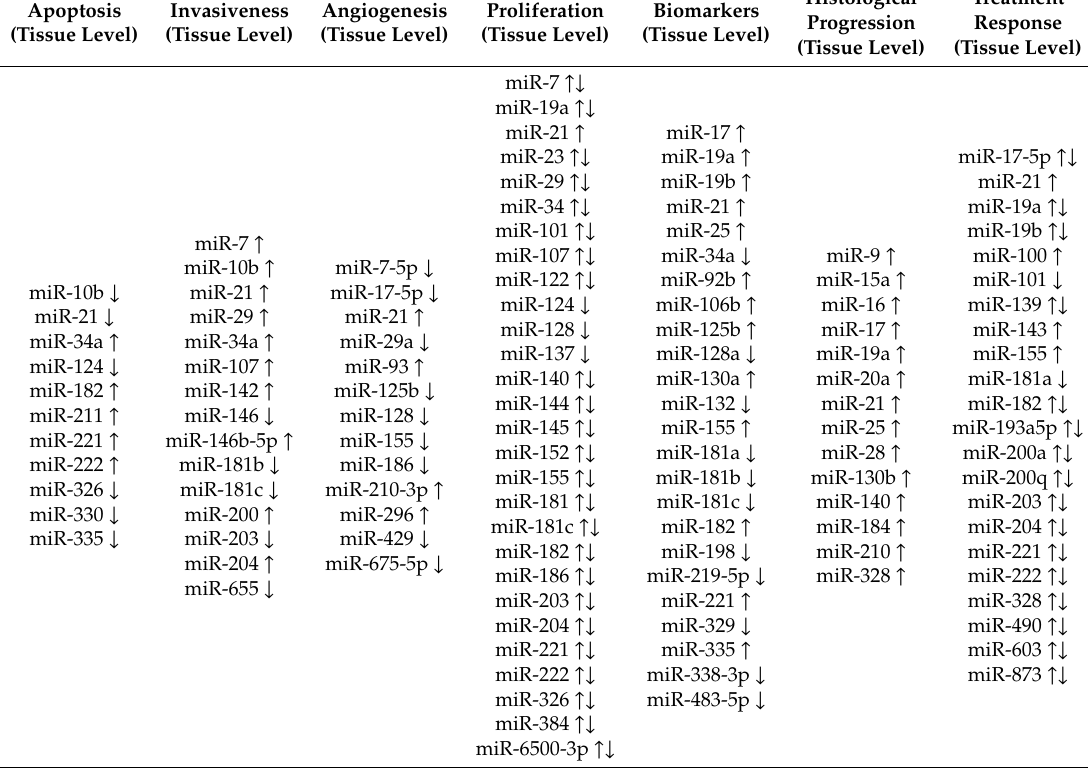
Table 1. Presentation of microRNA (miRNA) molecules, divided into major groups of action: carcinogenesis modulants (apoptosis, invasiveness, angiogenesis, proliferation), tumor indicators (biomarkers), tumor development controllers (histological progression) and treatment e ff ectiveness markers (treatment response). Arrows indicate = whether the levels of miRNA are increased, decreased or